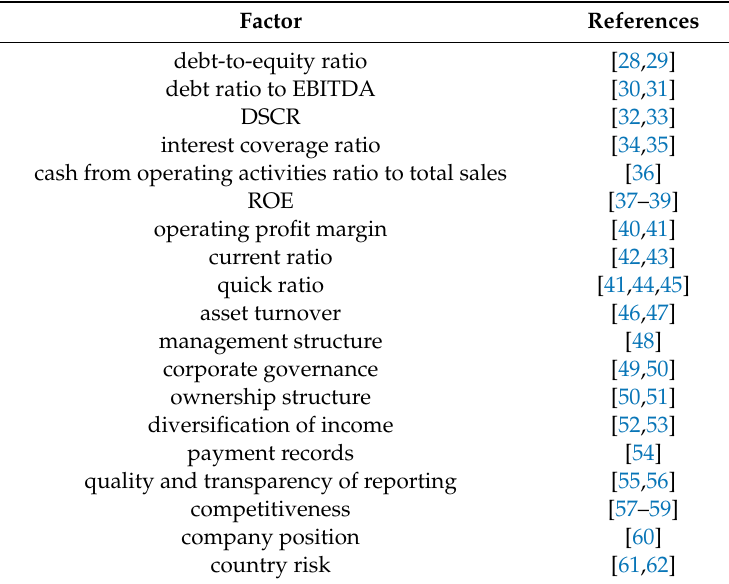
Table 3. References of variables.